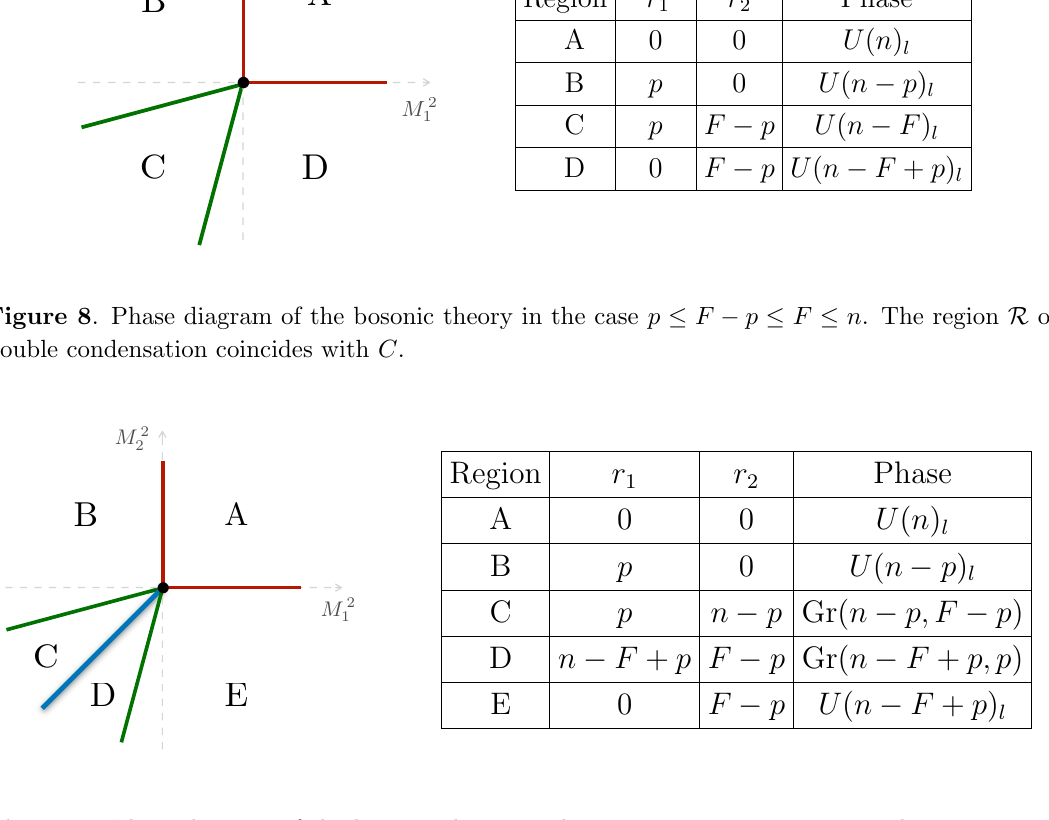
F p n < F . The region ≤ − ≤